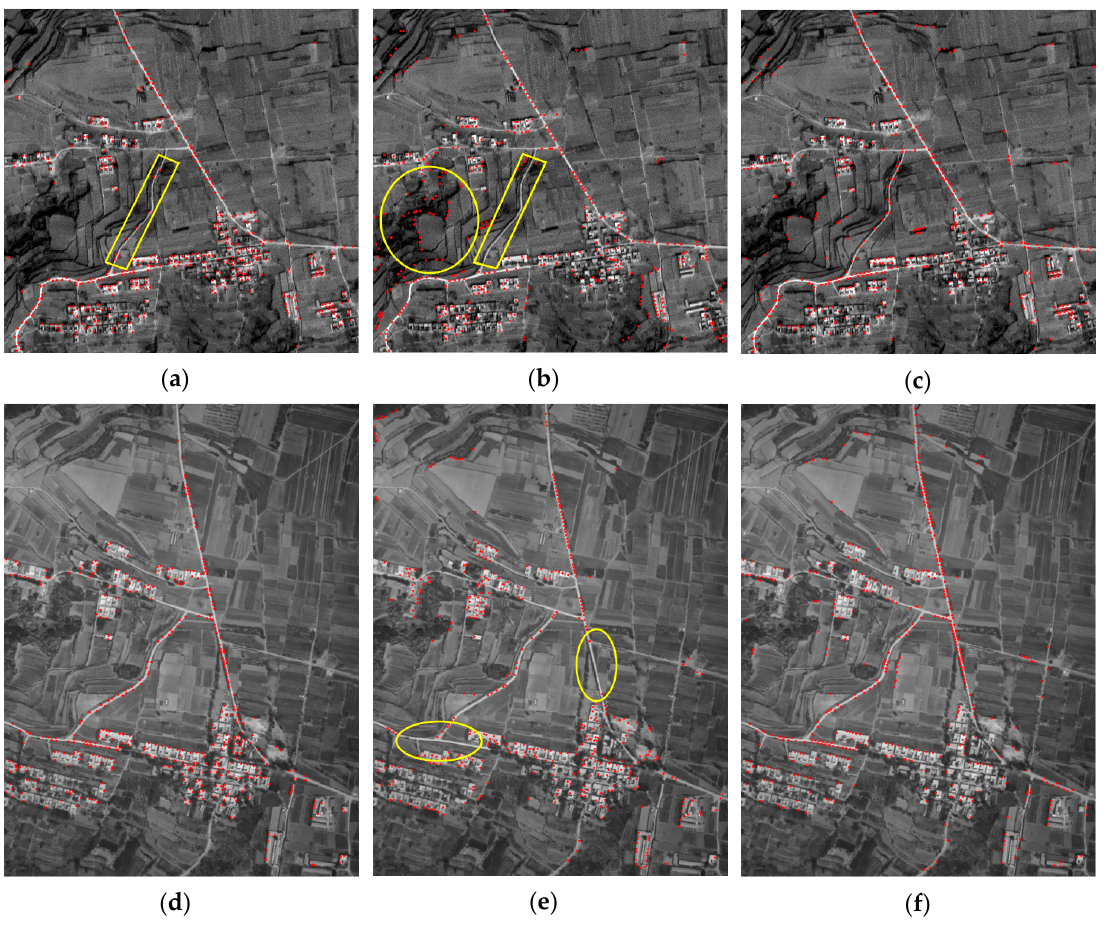
Figure 11. Feature-based preregistration results using different edge points extraction methods for the No. 4 image pair. ( a ) and ( d ) use the Canny algorithm to obtain edge points; ( b ) and ( e ) use the phase convergence model to obtain edge points; ( c ) and ( f ) use the ANDD-based ESM to obtain edge points.